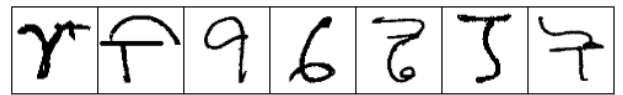
Figure 2. Bengali Basic Characters Samples from CMATERdb Dataset.